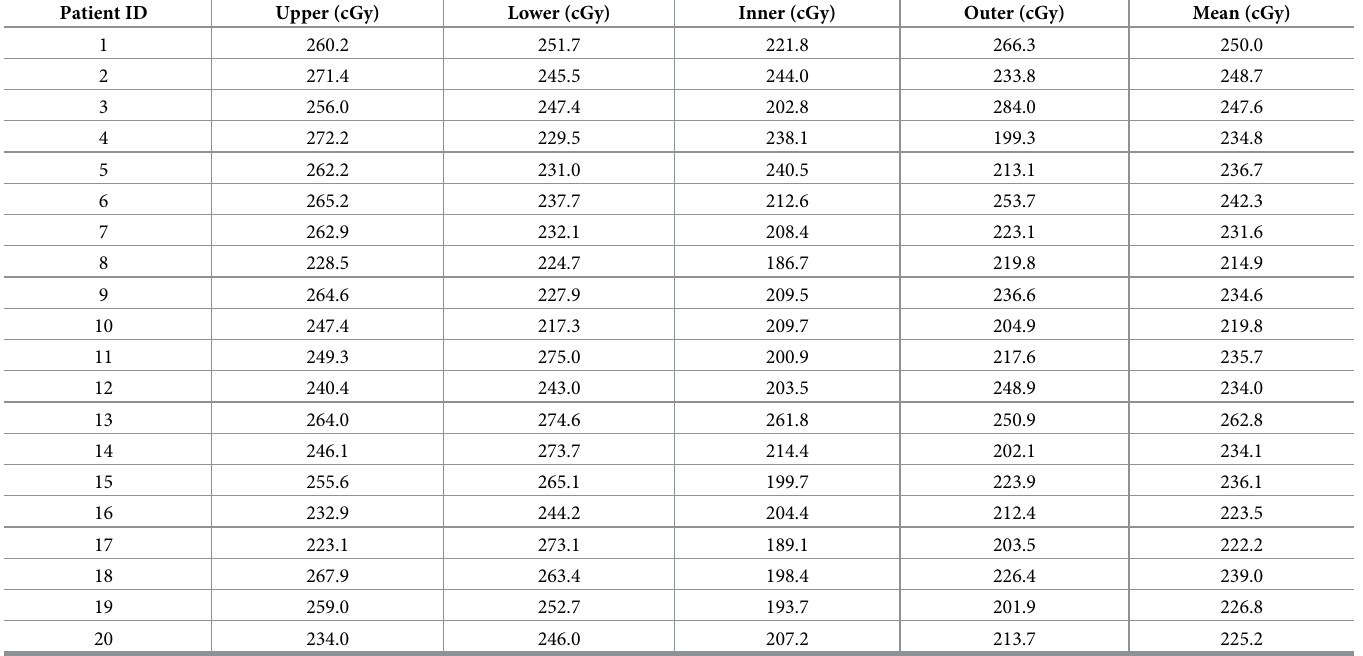
Table 2. Skin dose values measured using nanoDot optically stimulated luminescent dosimeters (OSLDs) for irradiated breast. Four measurement points were iden- tified on the upper, lower, inner, and outer sides of the irradiated breast. Patient ID